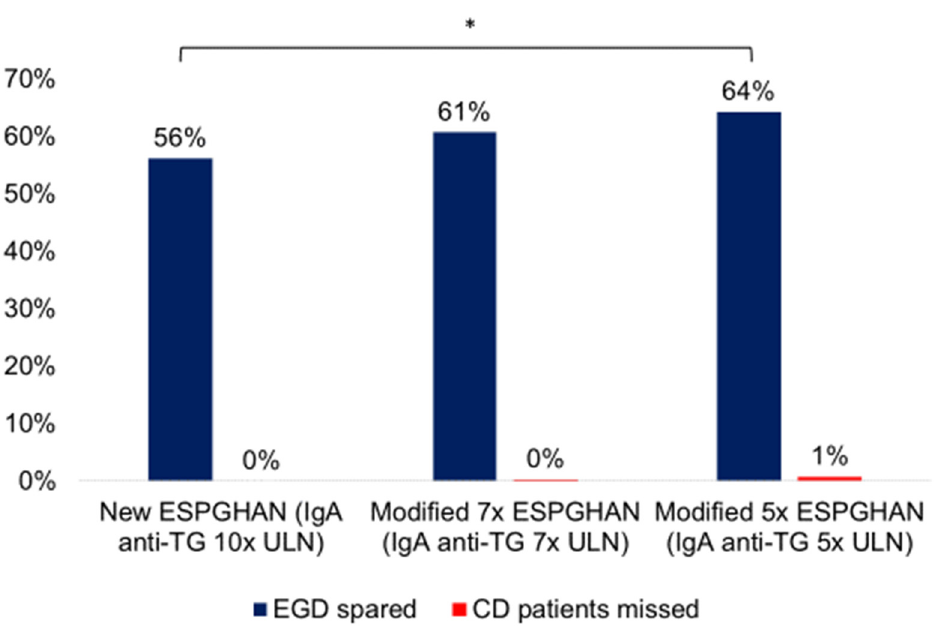
Figure 3. Performance of new and modified (7 × and 5 × ) ESPGHAN criteria in symptomatic CD patients (* for statistically significant differences, p <0.05). Abbreviations: IgA, immunoglobulin A; tTG, tissue transglutaminase; ULN, upper limit of normal; EGD, esophagogastroduodenoscopy; CD, celiac disease.